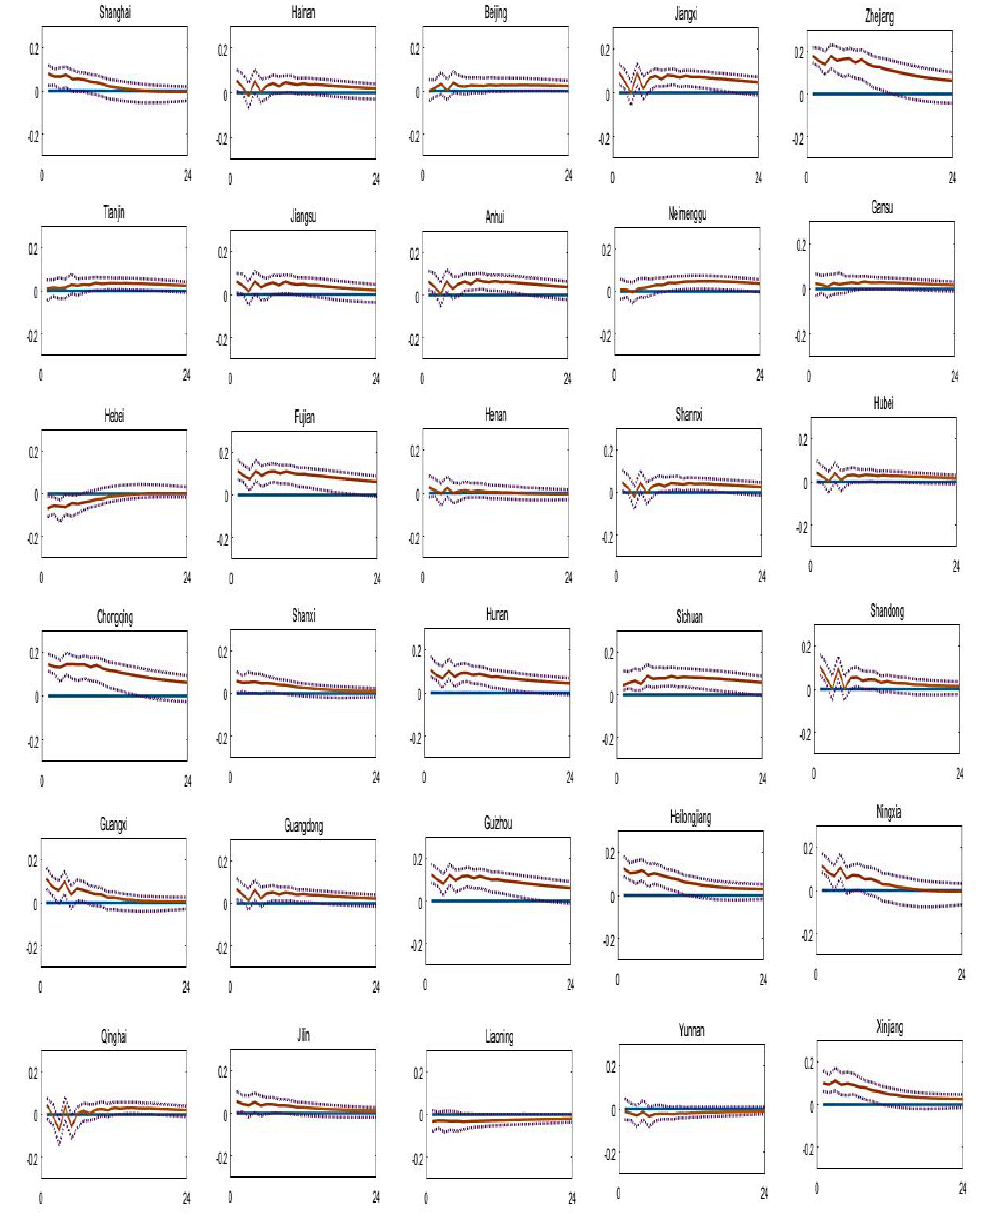
Figure 3. Impulse response of house prices to one standard error shock to M2: FAVAR system with one factor.